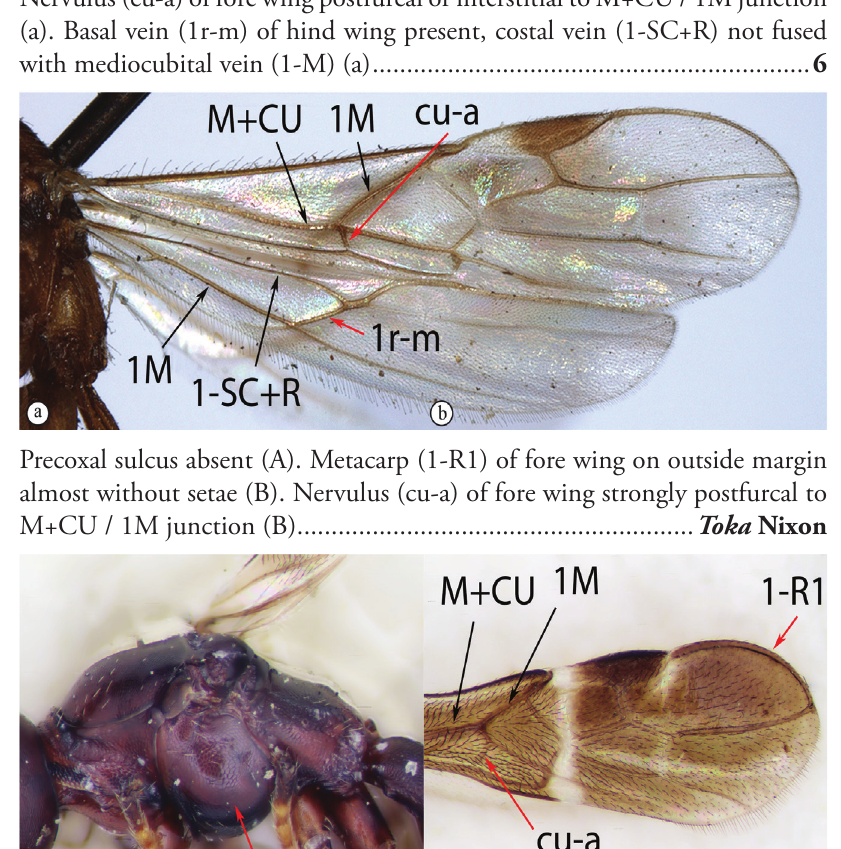
– Nervulus (cu-a) of fore wing postfurcal or interstitial to M+CU / 1M junction (a). Basal vein (1r-m) of hind wing present, costal vein (1-SC+R) not fused